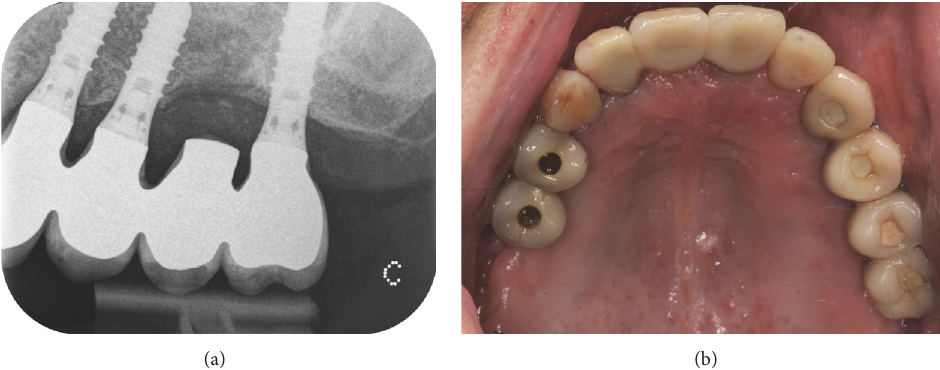
Figure 3: The implant 25 was removed and the bridge was rescrewed. The patient underwent antibiotic treatment. (a) Periapical radiograph and (b) clinical view.